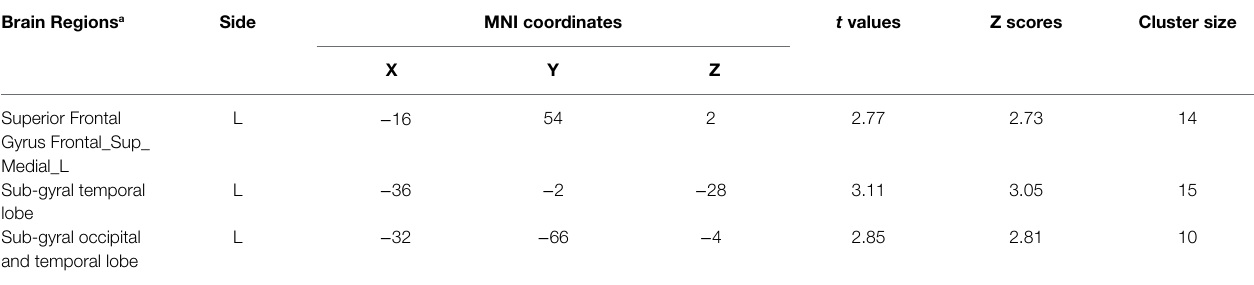
TABLE 1 | Activations associated with attachment security priming (Attachment priming > neutral